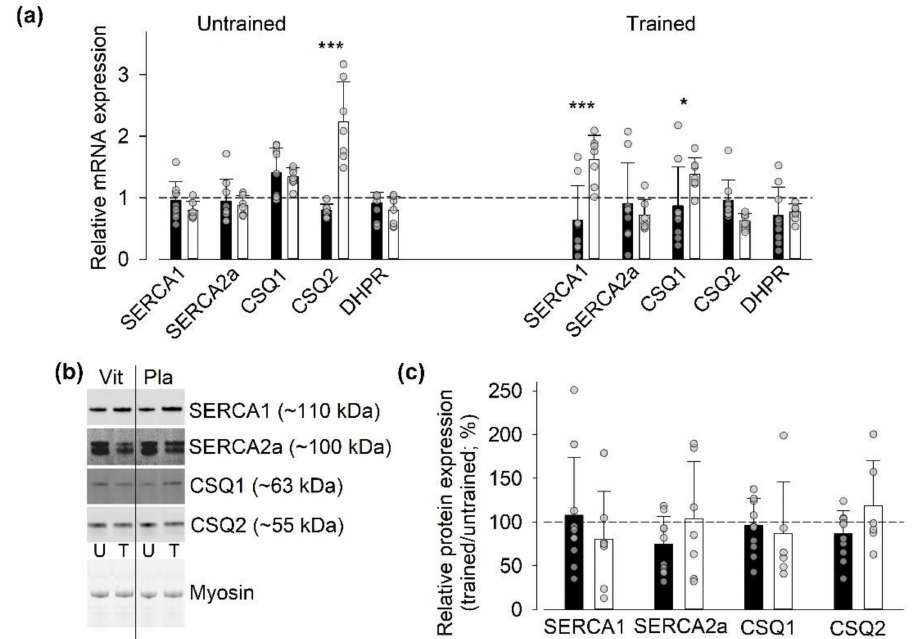
Figure 4. Limited SIT-induced changes in mRNA and protein expression of other SR Ca 2 + -handling proteins than RyR1. ( a ) Mean and individual data of the ratio of mRNA expression 1 h after to that before the first (Untrained) and last (Trained) SIT sessions in individuals treated with vitamins ( n = 9) or with placebo ( n = 7); dashed line indicates no di ff erence between before and after exercise. Two-way repeated measures ANOVA showed a general group di ff erence ( p < 0.01) in the untrained state. Di ff erence between vitamins and placebo groups in relative mRNA expression of individual genes: * p < 0.05, *** p < 0.001. ( b ) Representative original Western blots from one individual treated with vitamins (Vit) and one treated with placebo (Pla). Biopsies taken before the first (untrained, U) and the last (trained, T) SIT session. Lower panels show stain-free loading controls. ( c ) Mean and individual data of the relative protein expression in biopsies obtained in the untrained and the trained state in individuals treated with vitamins (n = 10) or with placebo ( n = 6–7). Data expressed as the ratio of the expression in the trained to that in the untrained state; dashed line indicate no di ff erence between the two states. No significant di ff erences between the untrained and the trained state or between vitamin and placebo-treated individuals were observed with two-way repeated measures ANOVA. Data are shown as mean ± SD; vitamin group, black bars; placebo group, white